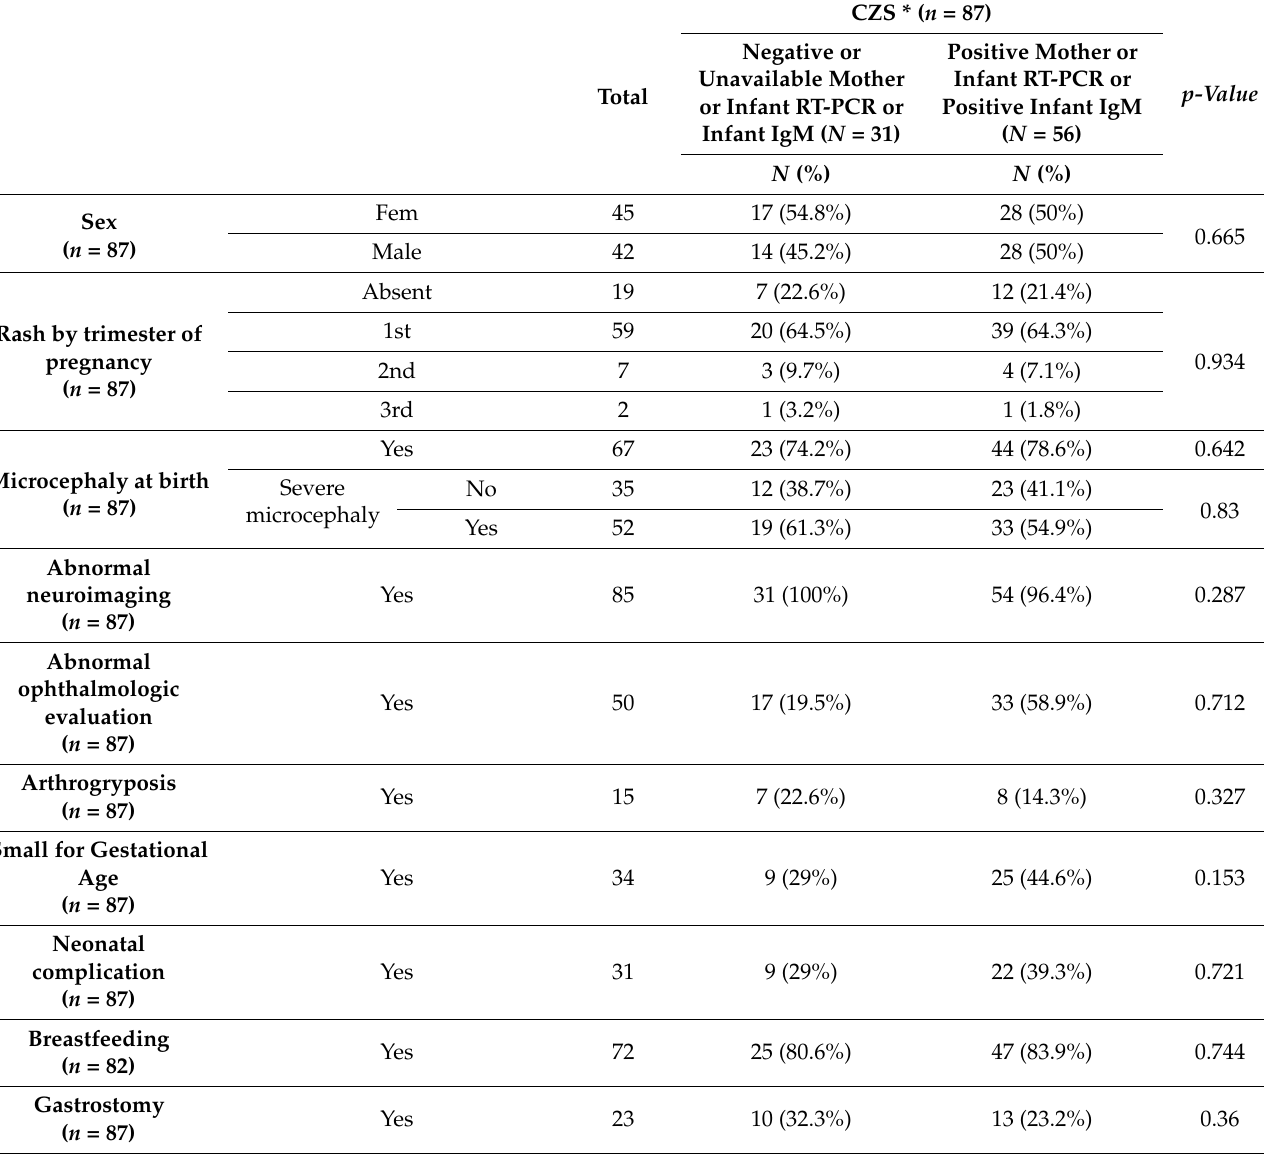
Table A1. Clinical and socioeconomic characteristics and follow-up complications of infants with laboratory confirmation of CZS versus not confirmed